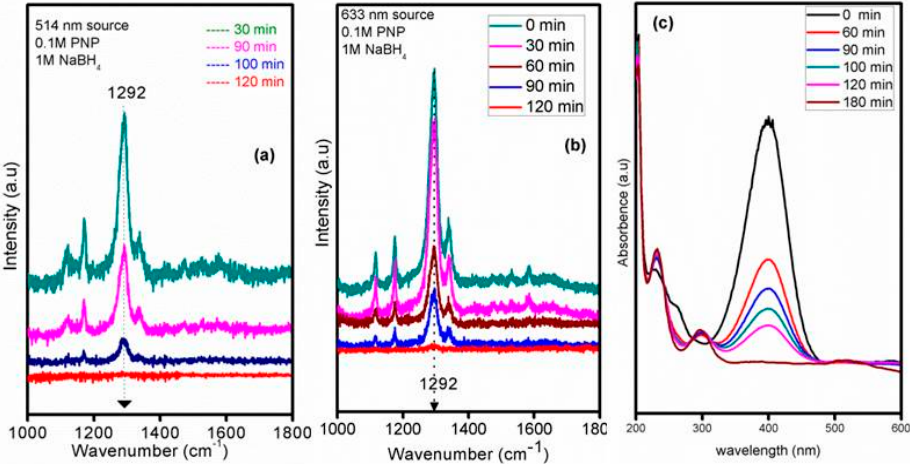
Figure 6. In situ Raman spectral data under ( a ) 514 nm ( b ) 633 nm laser source and ( c ) UV-Vis spectral data for the conversion of 4-nitrophenol to 4-aminophenol.